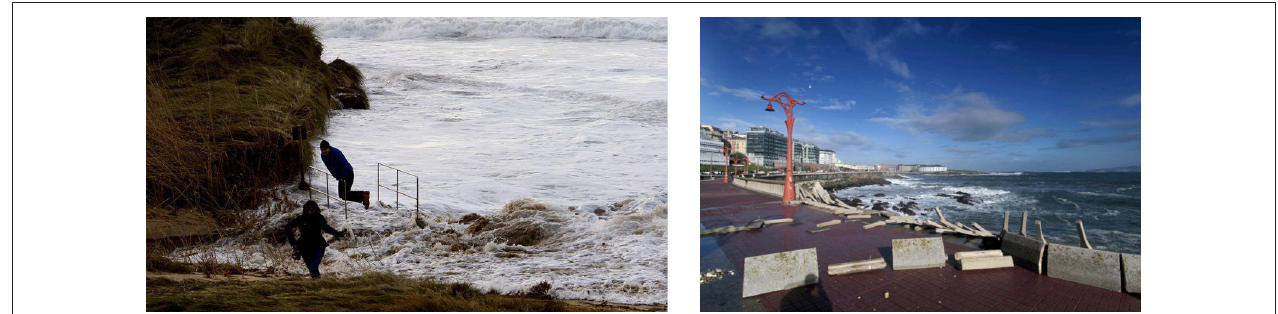
FIGURE 1 | Left: people running away from the waves at Esteiro beach (Xove, Lugo, Northern Galicia) during the storm of February 2nd 2014 (Nadja storm). Source: La Voz de Galicia, photographer: Pepa Losada: http://www.lavozdegalicia.es/album/galicia/2014/02/02/danos-temporal/01101391328868511590785.htm. Right: impact on Coruña maritime promenade after the same Nadja storm. Source: El Ideal Gallego: http://www.elidealgallego.com/album/coruna/efectos-temporal-coruna/ 20140202182014171505.html.